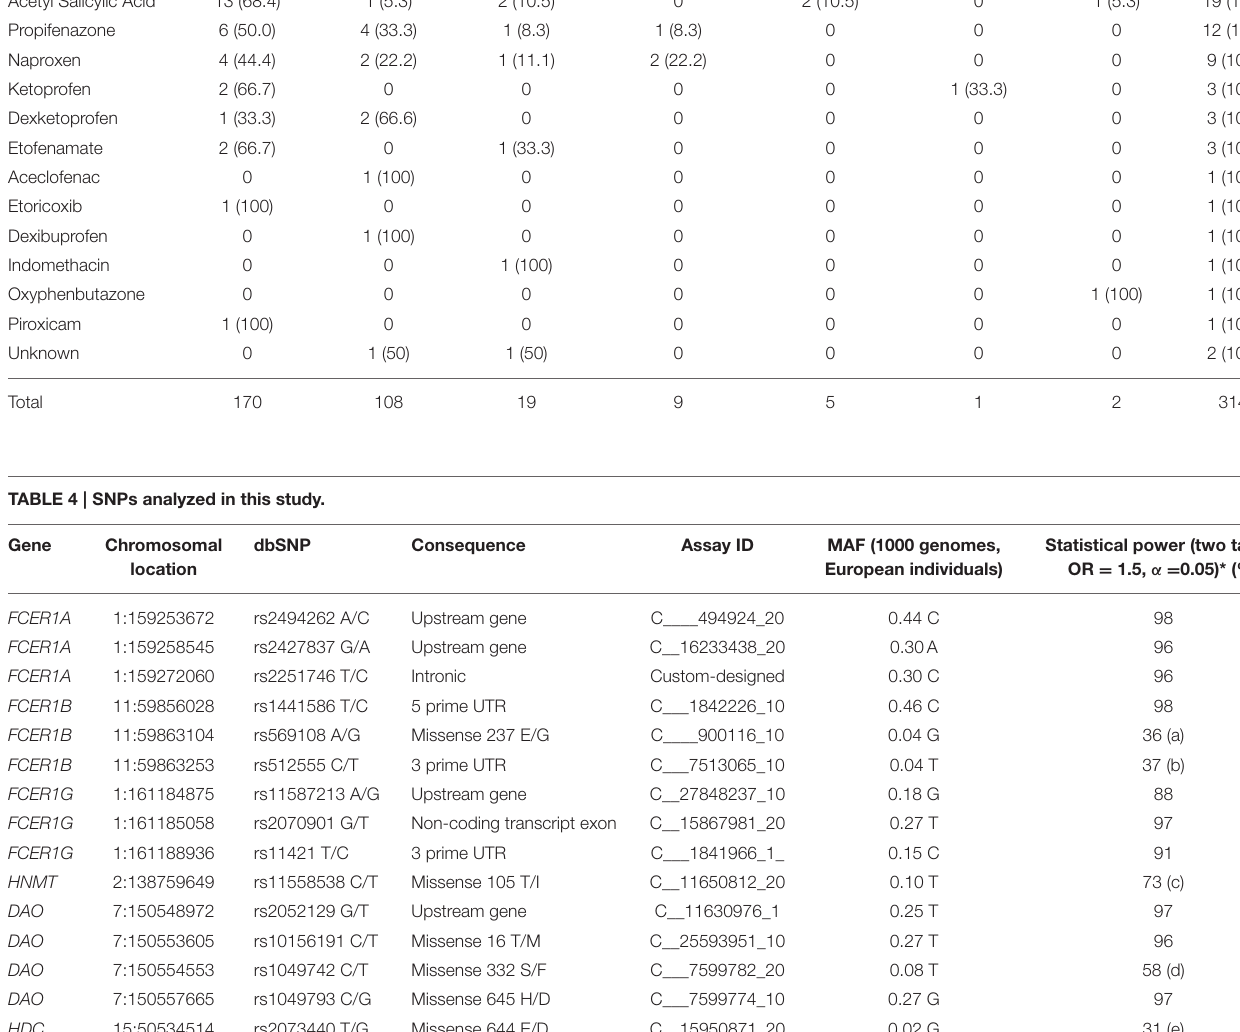
TABLE 3 | Clinical presentation of selective NSAID-induced hypersensitivity. Gender Urticaria + PATIENTS DISTRIBUTED BY CLINICAL PRESENTATION